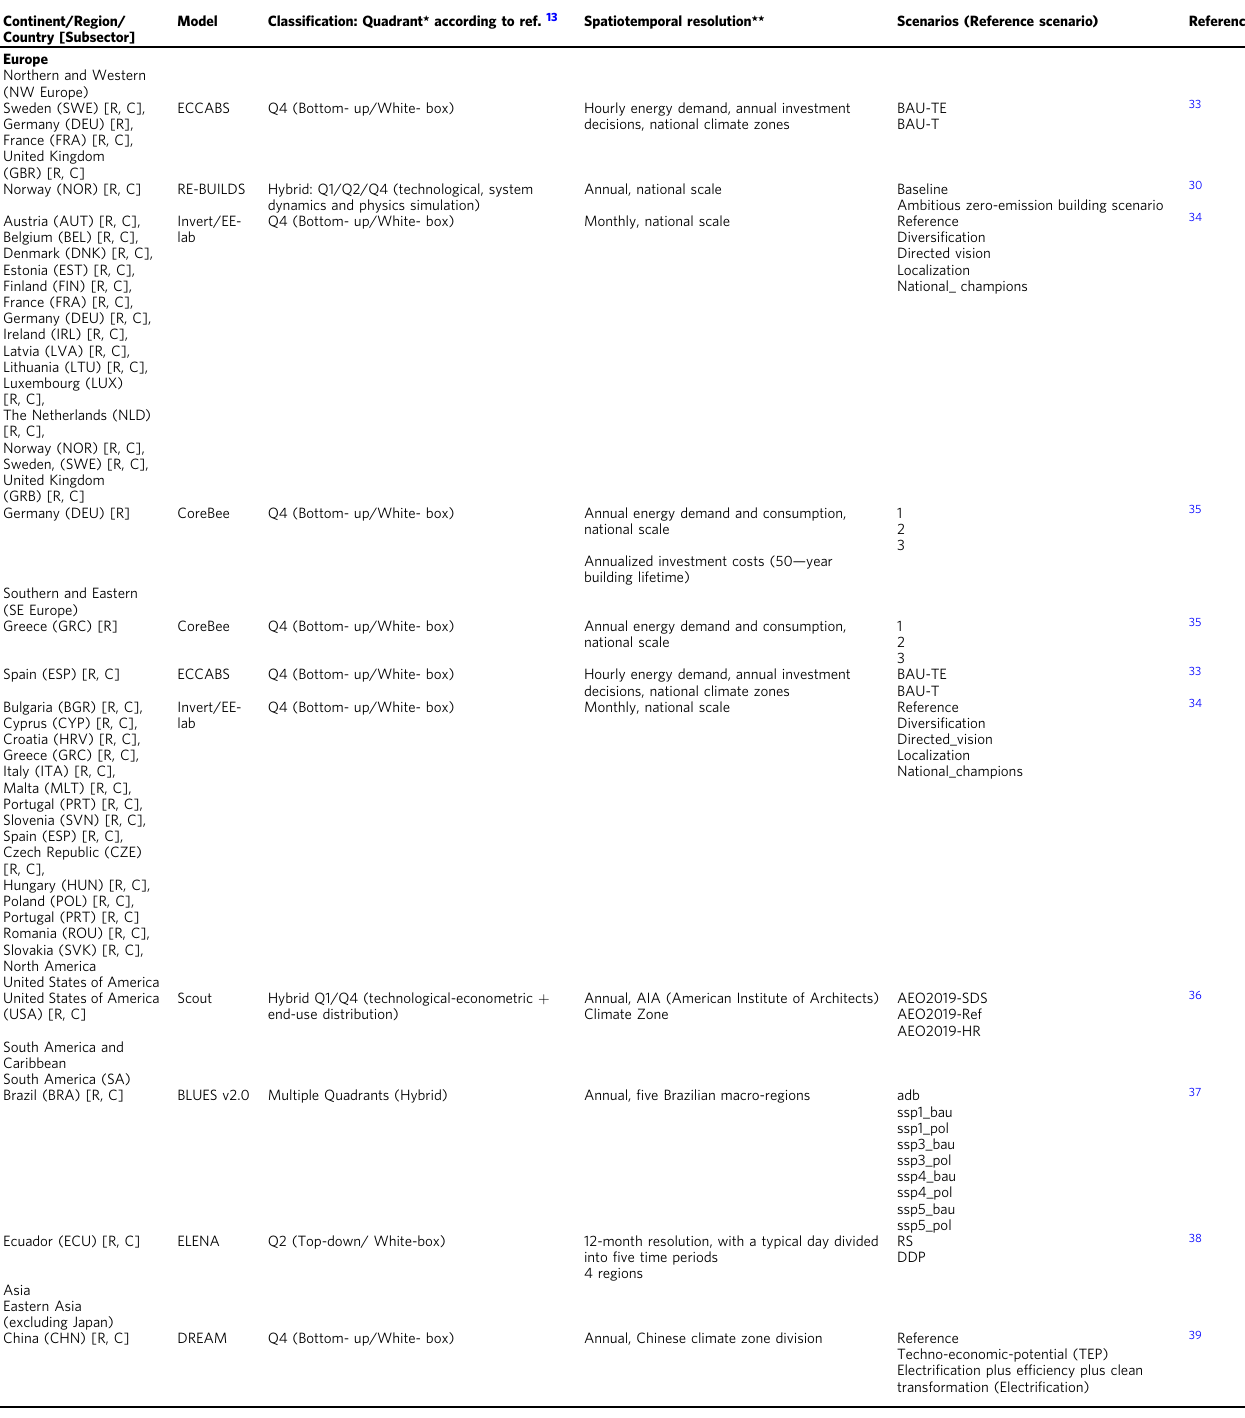
Table 1 Model overview per region and country. Subsectors: R, Residential; C, Commercial. Continent/Region/ Country